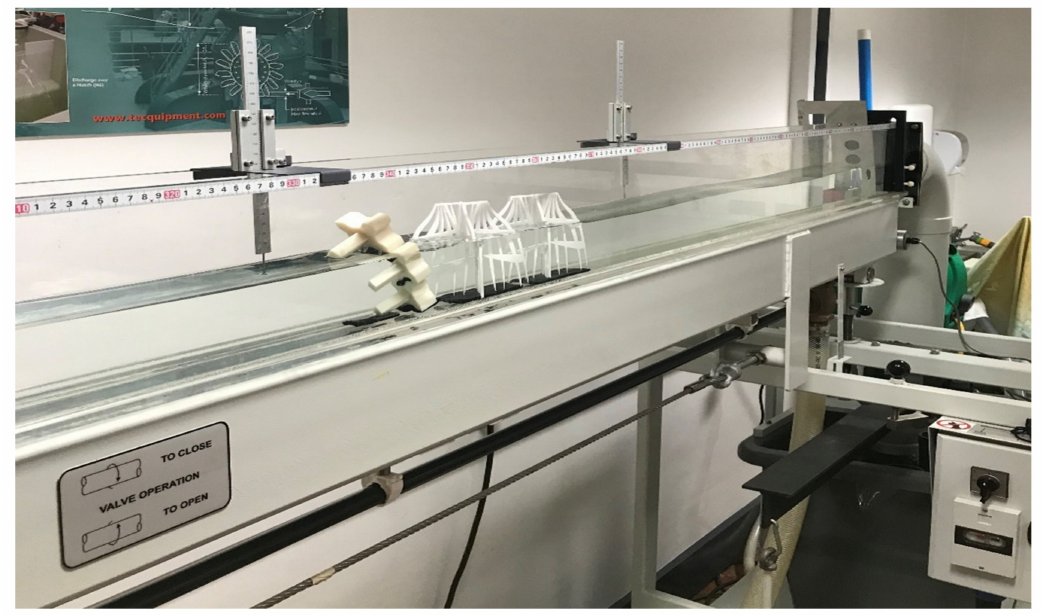
Figure 4. Typical arrangement of one Xbloc wall with two mangrove roots inside a 5 m flume